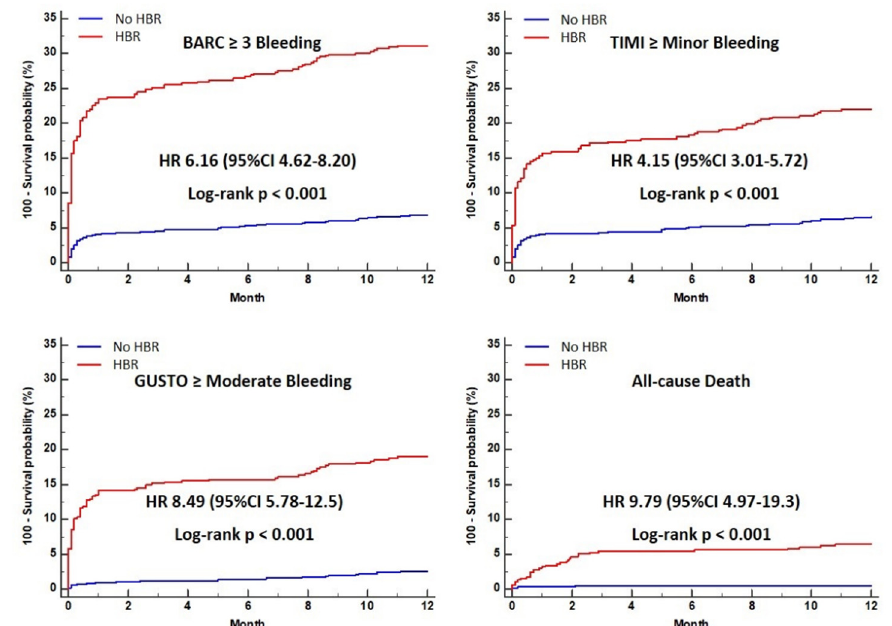
Figure 1. Cumulative incidence curve of clinical outcomes in HBR and no-HBR groups. BARC, Bleeding Academic Research Consortium; CI, confidence interval; GUSTO, Global Use of Strategies To Open coronary arteries; HBR, high bleeding risk; HR, hazard ration; TIMI, Thrombolysis in Myocardial Infarction.